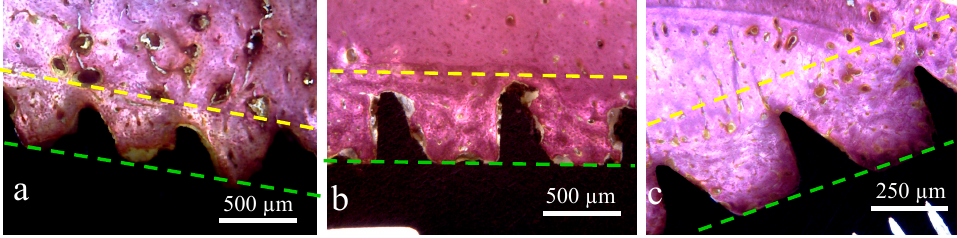
the size (depth) presented by the implant threads and the extension of these events.